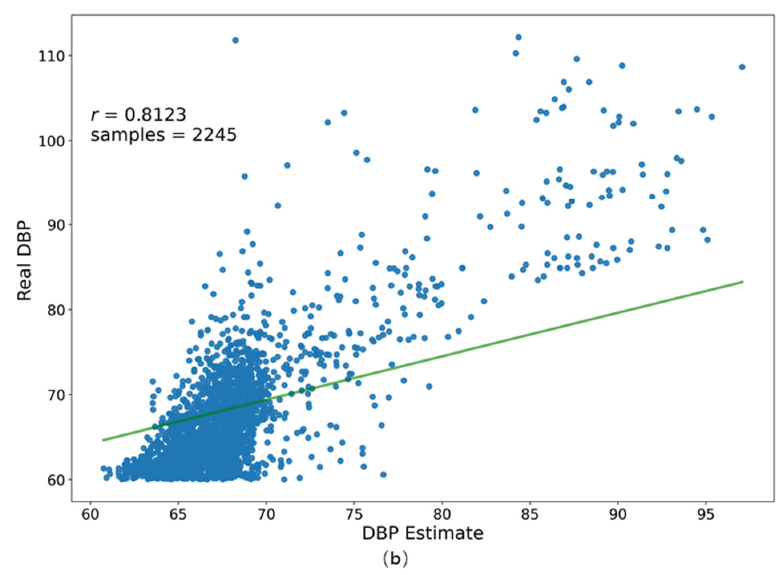
Figure 7. Regression diagram of SBP ( a ) and DBP ( b ).